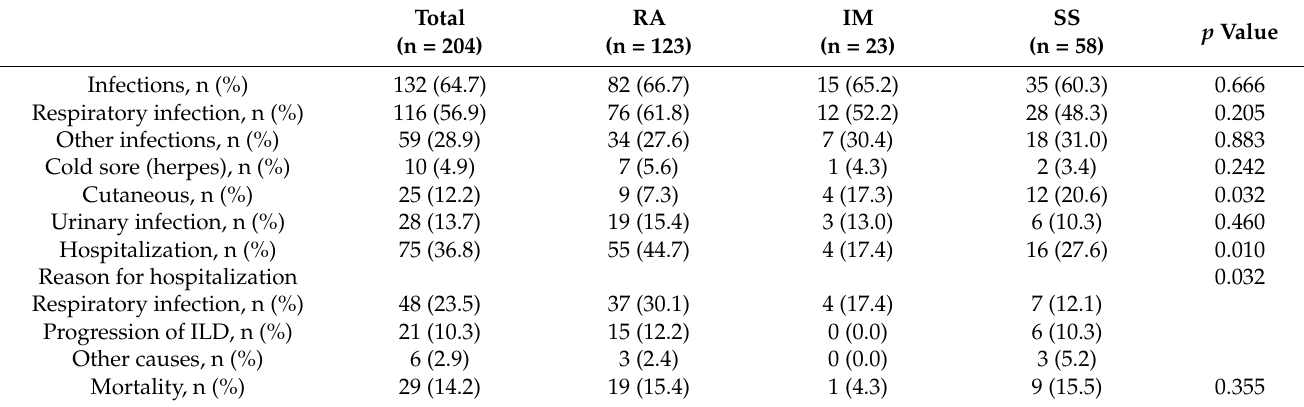
Table 2. Clinical